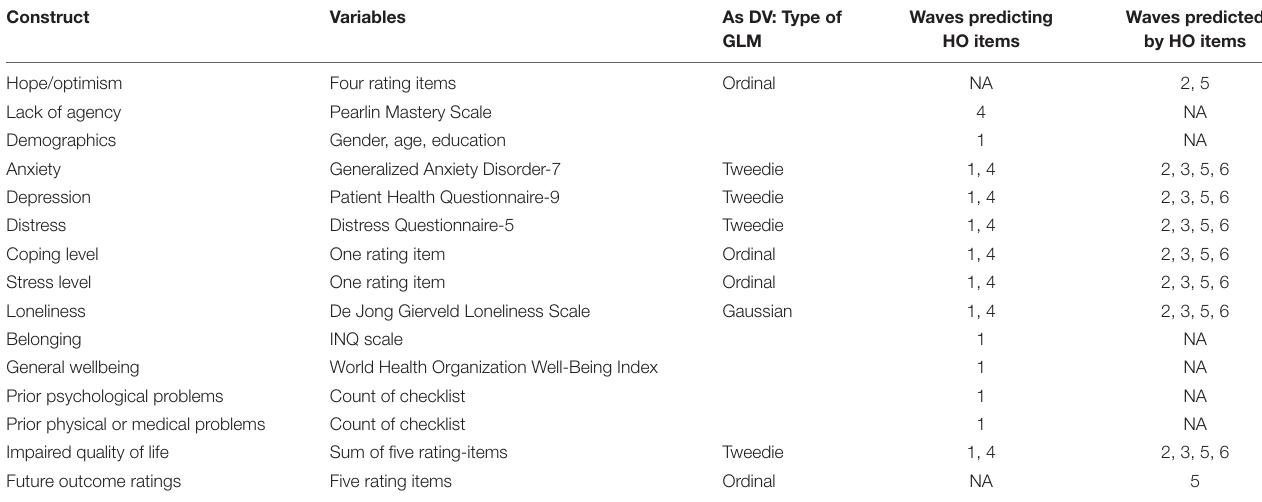
TABLE 1 | Relevant constructs and variables.